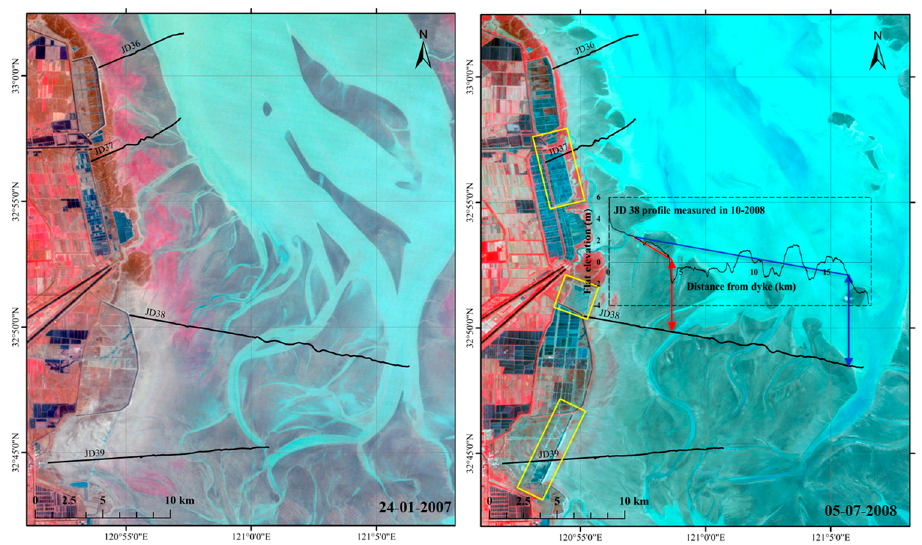
Figure 5. Satellite image of the JD 36 to 39 from Landsat 7 ETM on 24 January 2007 ( left panel ) and 5 July 2008 ( right panel ). The yellow box indicates the human interventions taking place between these two image times. The dash black box indicates the measured profile JD38 in October 2008, and the red and blue lines in the dash box are associated with two beach slope calculation meth- ods.